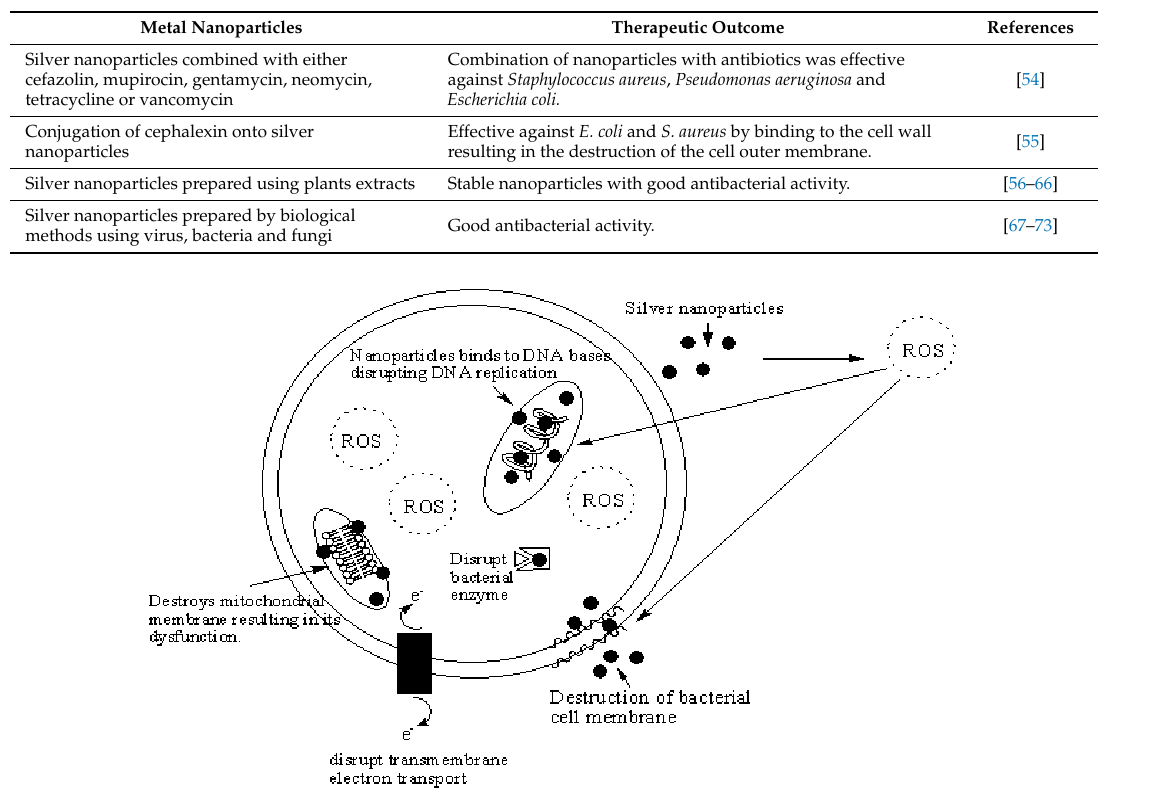
Figure 2. Mode of action of nanoparticles on bacteria.